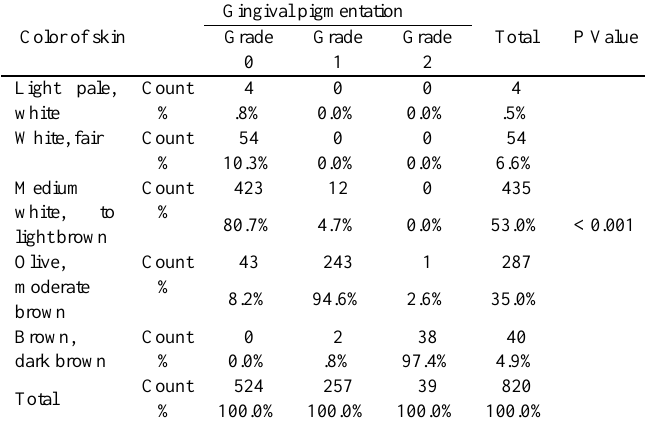
Table 2: Association between Gingival Pigmentation and